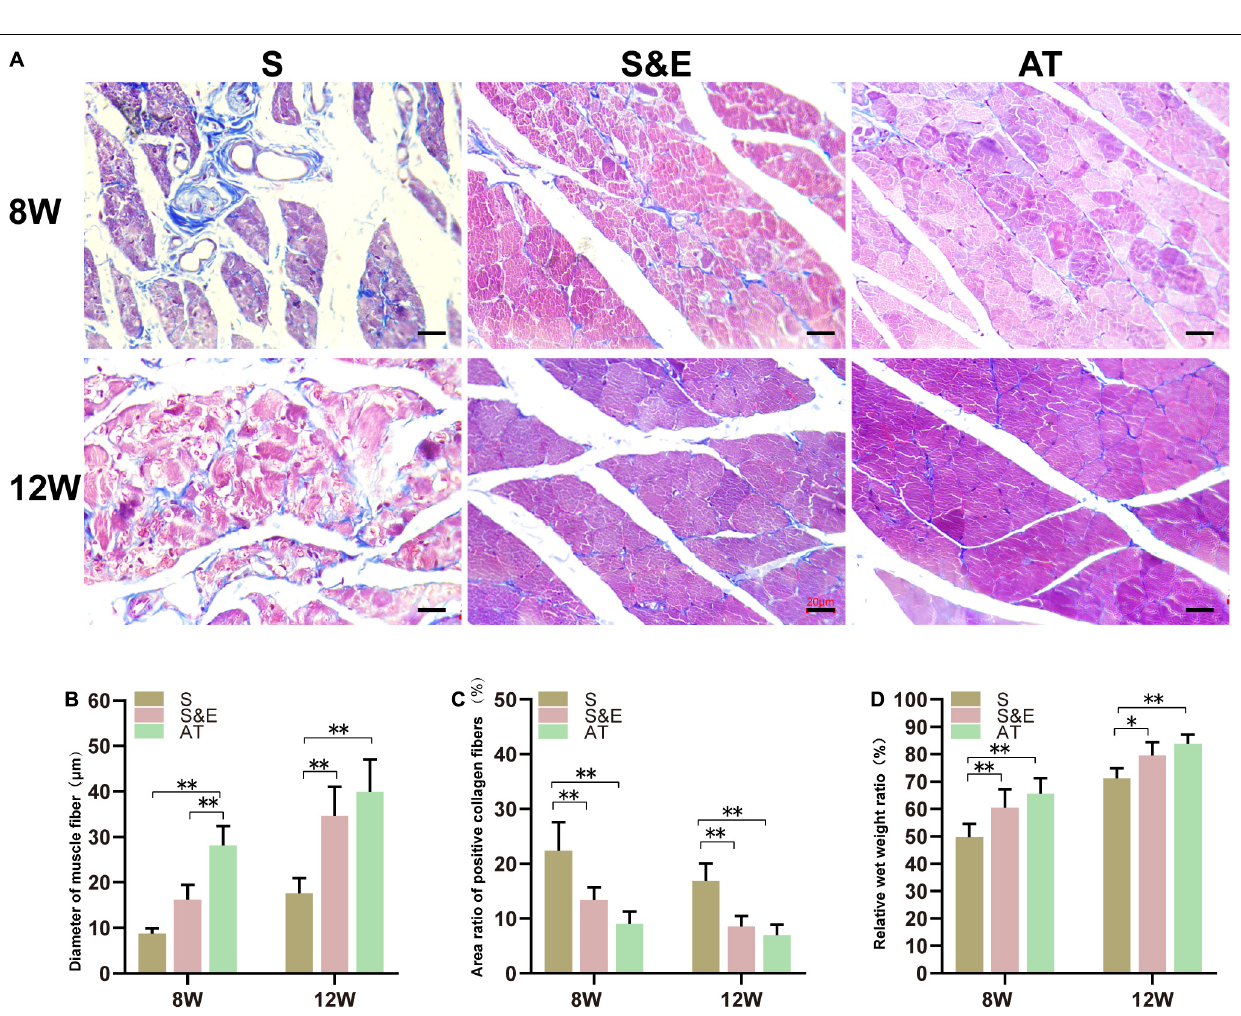
Frontiers in Neuroscience |